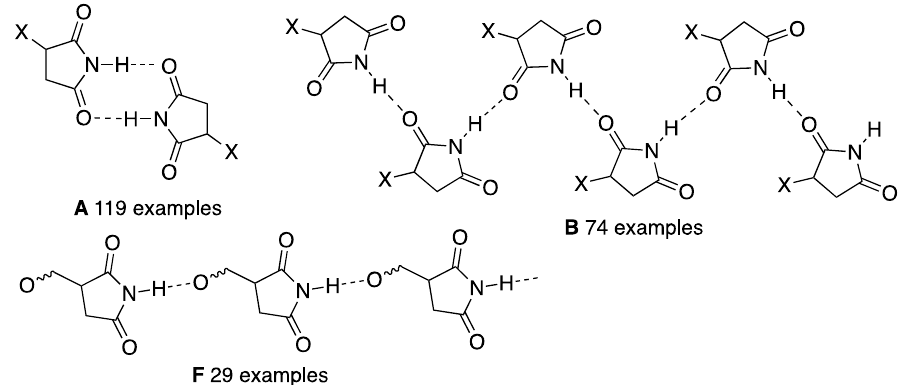
Figure 1. Most common previously reported hydrogen bonding patterns.